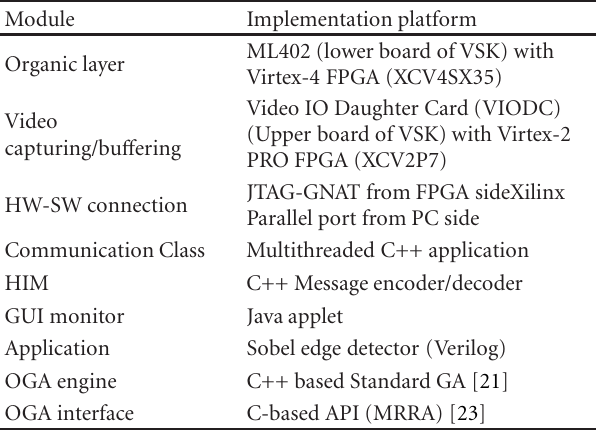
Table 3: System modules